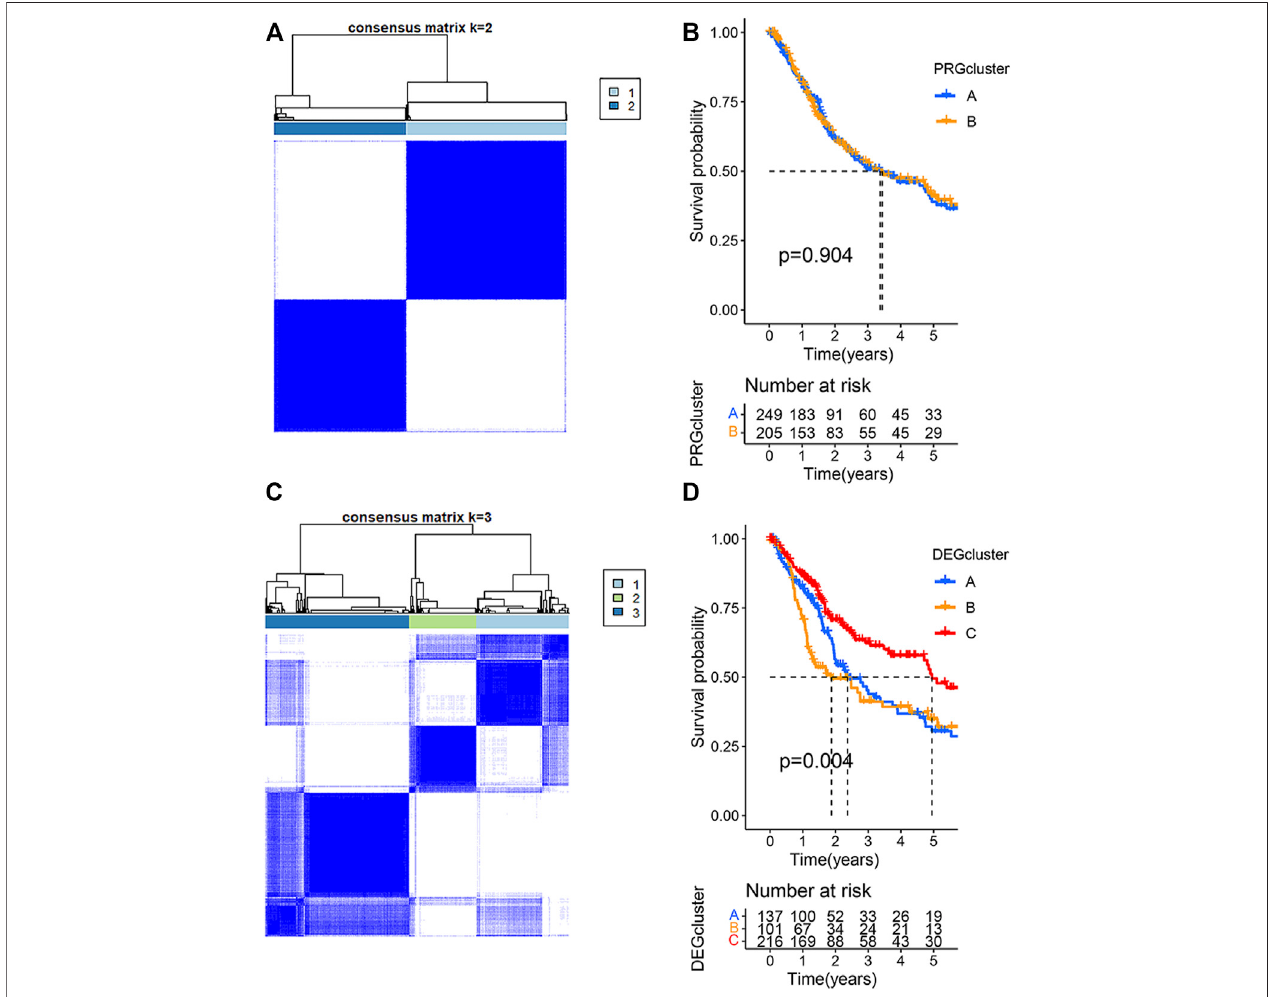
FIGURE 2 | Clustering analysis of pyroptosis-related genes (PRGs) in bladder urothelial carcinoma using the TCGA and GSE19423 cohorts. (A) The consensus clustering algorithm showed that the optimal number of clusters was two based on the PRG expressions. (B) The survival analysis of two PRGcluster subtypes using Kaplan – Meier curves. (C) The optimal number ofclusters was three based on the expression of two PRGcluster subtype- related differentially expressed genes (DEGs). (D) Survival analysis of three DEGcluster subtypes using Kaplan – Meier curves.